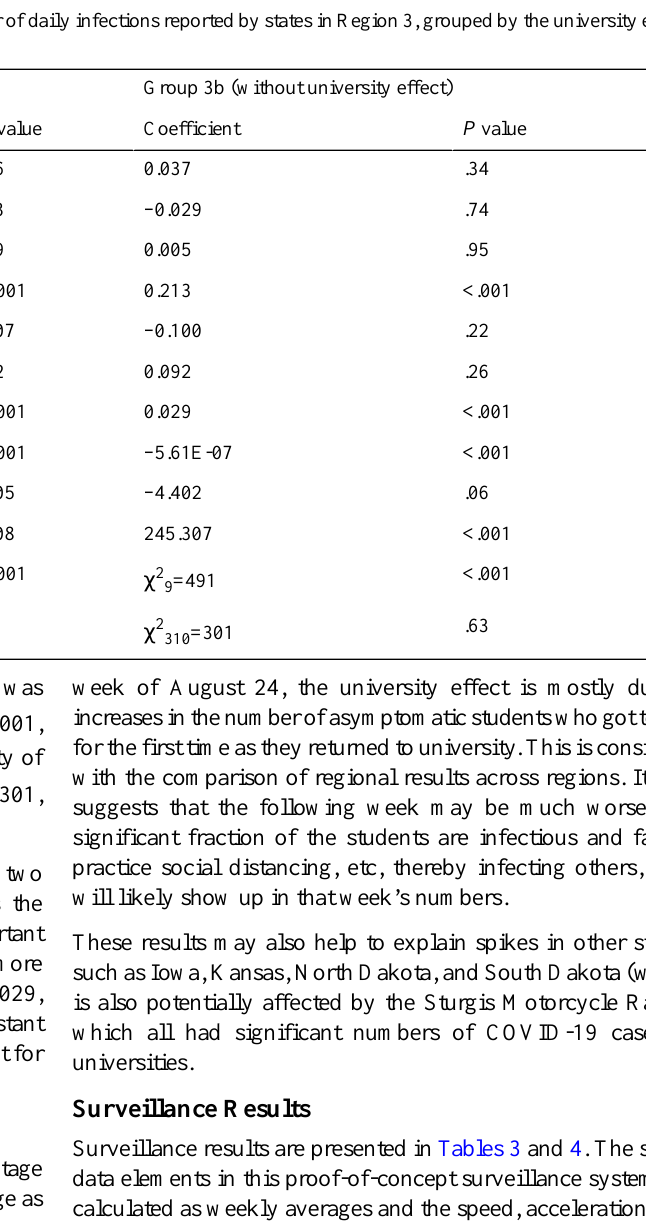
Table 2. Arellano-Bond dynamic panel data modeling of the number of daily infections reported by states in Region 3, grouped by the university